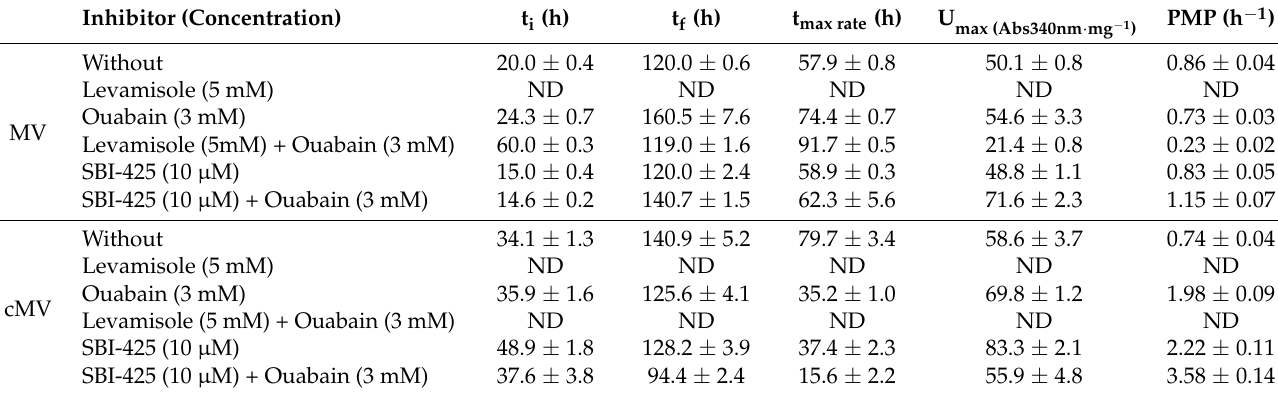
Figure 3. MV ( A ) and cMV ( B ) were incubated in 96 wells plates with SCL for 120 h at 37 °C in an incubation hydrated chamber. The SCL medium with 2.0 mM of CaCl 2 was supplemented with the inhibitors Levamisole 10.0 mM, SBI-425 10 μ M and Ouabain 3.0 mM either alone or in combination as indicated. Samples were pre-incubated for 30 min before the addition of 3.41 mM ATP. The absorbance at 340 nm was measured within 24 h intervals and normalized by protein concentration generating Abs 340nm /mg data and resulting in the kinetic parameters presented on Table 3, as described in Materials and Methods. Control (absence of inhibitor) ( ■ black); Levamisole, phosphatase inhibitor (red ● ); SBI-425, TNAP specific inhibitor (cyan ♦ ); Ouabain, NKA specific inhibitor (green ▲ ); Levamisole + Ouabain ( ▼ blue); SBI-425 + Ouabain ( ◄ pink). Table 3. Kinetic parameters of nucleation process obtained from the mineralization curves for MV and cMV, after 120 h assay in SCL buffer supplemented with 2.0 mM of CaCl 2 , and inhibitors. Data are reported as the mean ± SD of triplicate measurements of three different MV preparations. Inhibitor (Concentration) t i (h) t f (h) t max rate (h) U PMP (h − 1 ) max (Abs340nm · mg − 1 ) Without 20.0 ± 0.4 120.0 ± 0.6 0.86 ± 0.04 Levamisole (5 mM) ND ND ND ND Ouabain (3 mM) MV Levamisole (5mM) + Ouabain (3 mM) 60.0 ± 0.3 SBI-425 (10 µ M) SBI-425 (10 µ M) + Ouabain (3 mM) Without Levamisole (5 mM) Ouabain (3 mM) cMV Levamisole (5 mM) + Ouabain (3 mM) SBI-425 (10 µ